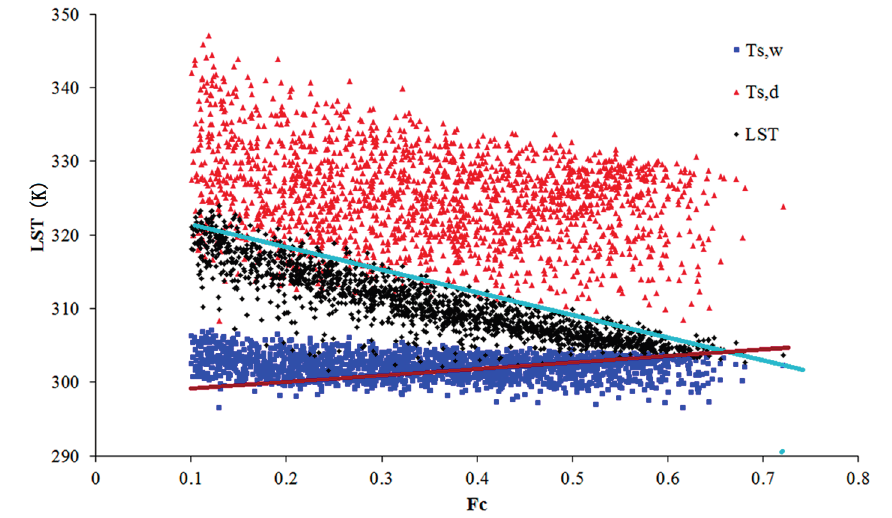
Figure 8. Comparison between the position of theoretical dry/wet pixels from SEBI and the dry/wet boundaries derived from LST-Fc diagram using the moderate resolution AATSR image Window B. Red points represent the T s,d and blue points represent the T s,w . The cyan line indicates the dry edge and purple line indicates the wet edge derived by from LST-Fc feature